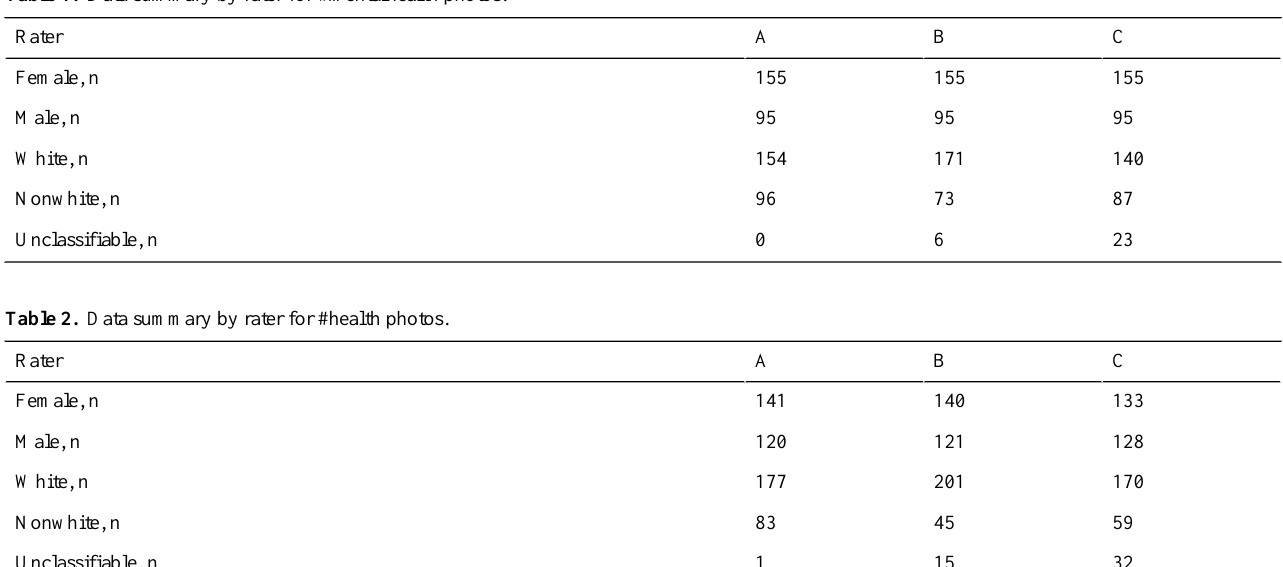
Table 1. Data summary by rater for #mentalhealth photos.